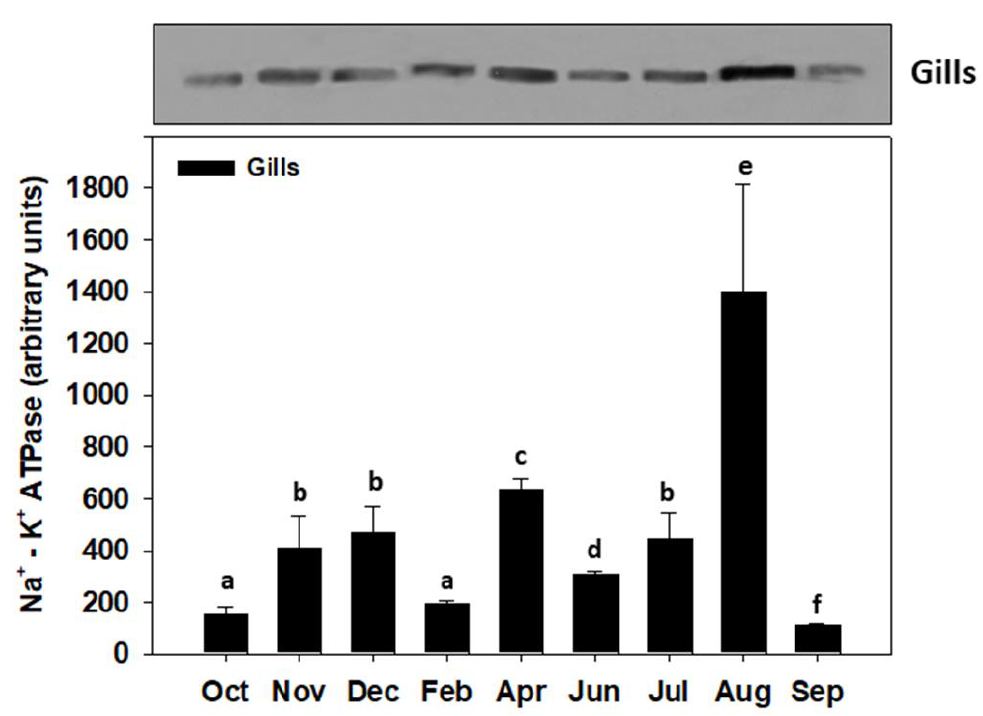
Figure 5. Na + -K + ATPase levels (mean ± SD) in the gills ( n = 5) of Alburnus vistonicus in Vistonis lake (Northern Greece), during the sampling period (October 2014–September 2015). Samplings were performed on a monthly basis. Representative blot is presented. Significant differences ( p < 0.05) between sampling months are presented as lower case letters. No sampling was conducted in January 2015.